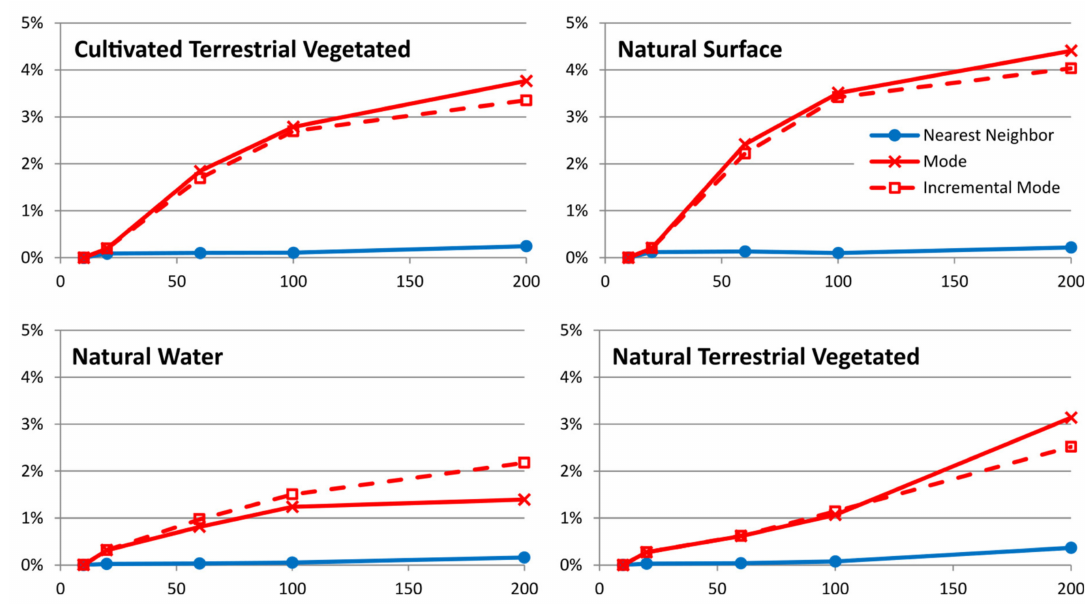
Figure 3. Absolute maximum variation (all studied protected areas) of each category area related to the same category area at original resolution. Same legend applies to all graphics. Only categories with variations higher than 2% are shown. Please refer to Section S1 of Supplementary Material for graphs of the other